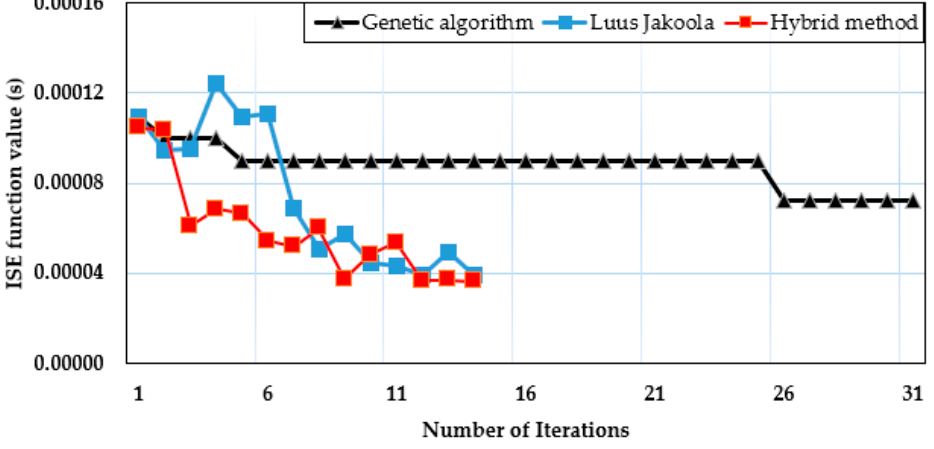
Figure 15. Tuning methods comparison for DSDF driving.